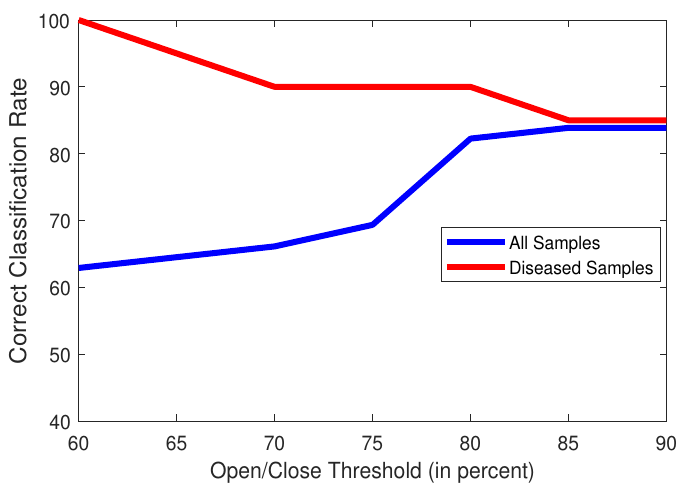
Figure 11. Plot of classification accuracies of all samples (blue) and only diseased samples (red) vs. Open/Close Threshold (in percent of Total No. of